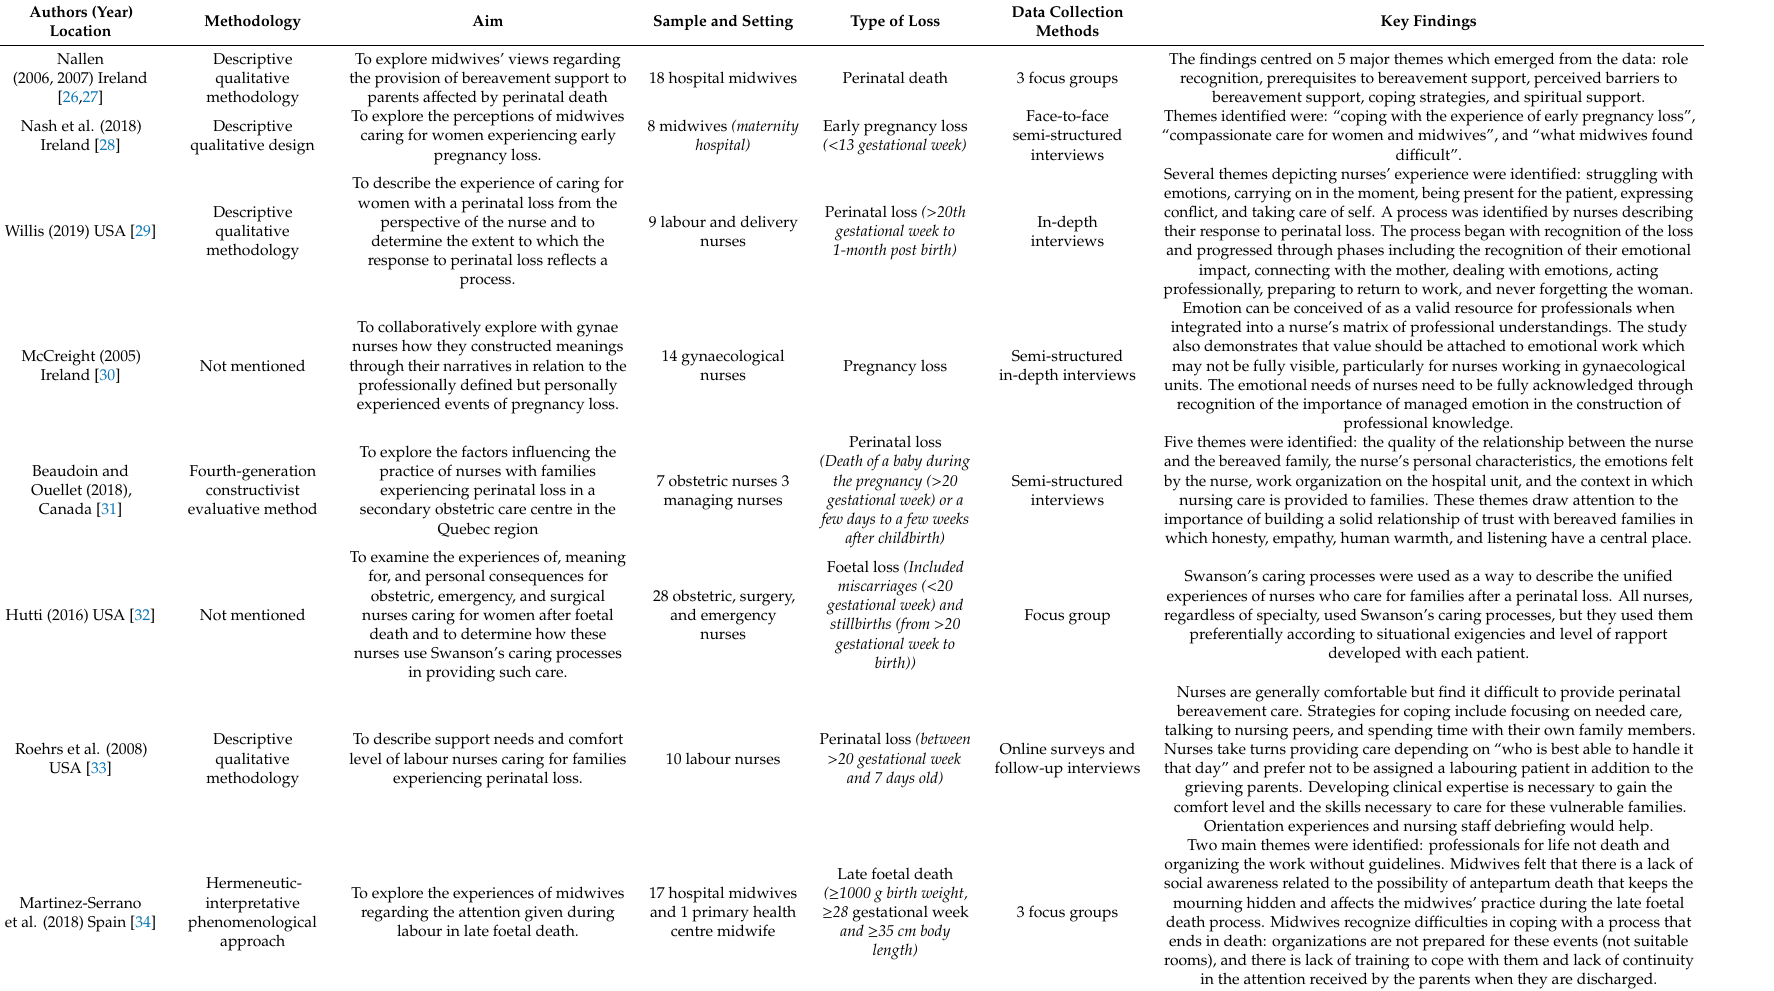
Table 2. Characteristics of included